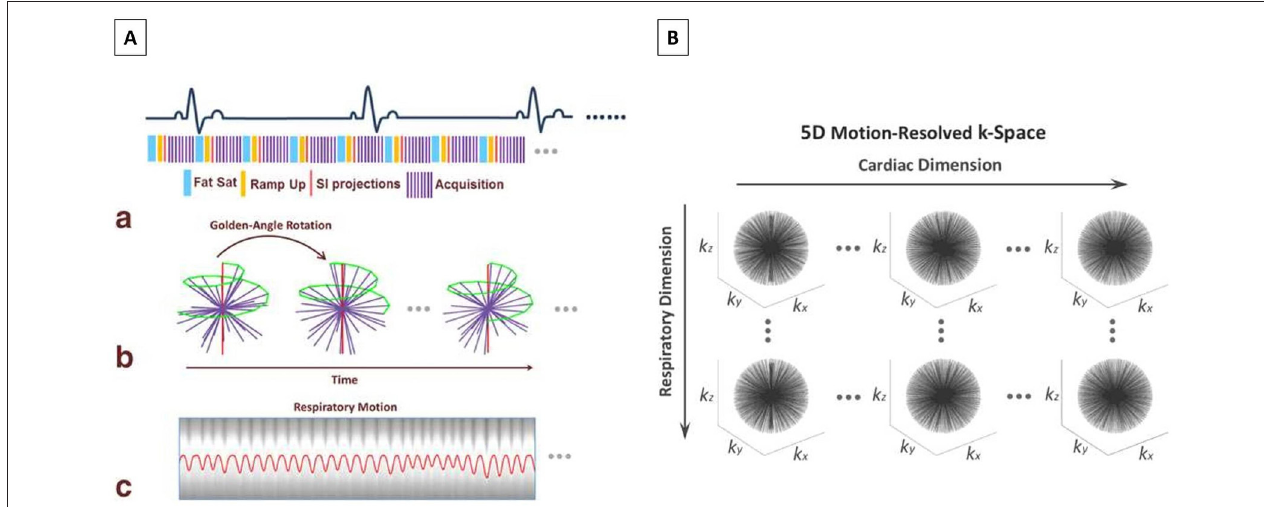
FIGURE 5 | (A) Data acquisition scheme and respiratory motion extraction for non–ECG-triggered whole-heart imaging. (a) A 3D radial b-SSFP sequence that is segmented into multiple interleaves (purple lines) is used for MR data acquisition. Each interleave starts with a spoke oriented along the superior to inferior direction for self-navigation (red lines) and is preceded by fat saturation (blue lines). Ten additional ramp-up RF pulses (yellow lines) are deployed between the fat saturation module and the data acquisition window to restore restoring steady-state at each interleave. (b) 3D radial sampling trajectory based on the spiral phyllotaxis pattern. Each interleave is rotated by the golden-angle (137.51 ◦ ) about the z-axis, starting with a self-navigation spoke (red lines) for respiratory motion extraction. (c) An extracted respiratory motion signal is superimposed to the 1D FFT of an example series of SI readouts. (B) The acquired k-space is sorted into a 5D dataset ( k x -k y -k z - cardiac phase-respiratory phase) using respiratory motion signal extracted from self-navigators and cardiac motion signal obtained from recorded ECG time stamp. The datasets are first binned into different cardiac phases with a desired temporal resolution, then each cardiac phase is further sorted into multiple respiratory motion phases spanning from end-expiration to end-inspiration. The data sorting process is performed such that the number of spokes grouped in each temporal phase is the same. SSFP, Steady State Free Precession; MR, Magnetic Resonance; RF, Radiofrequency; FFT, fast Fourier transform; SI, Superior-Inferior; ECG, Electrocardiogram. Adapted with permission from Feng et al.